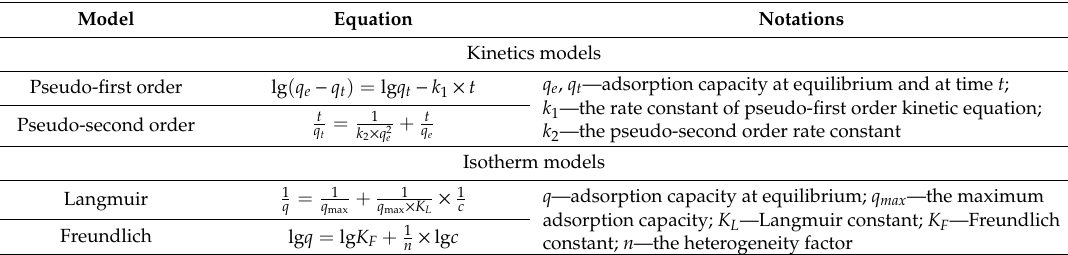
Table 1. Linear equations of isotherm and kinetics models used for the analysis of the experimental results [33,34].